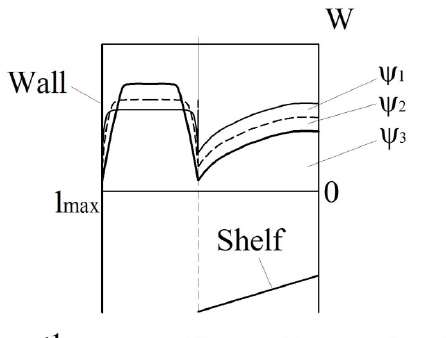
Figure 3. Vertical velocity profiles over the shelf and in the outloading space, depending on the shelf perforation degree ψ (qualitative distribution).